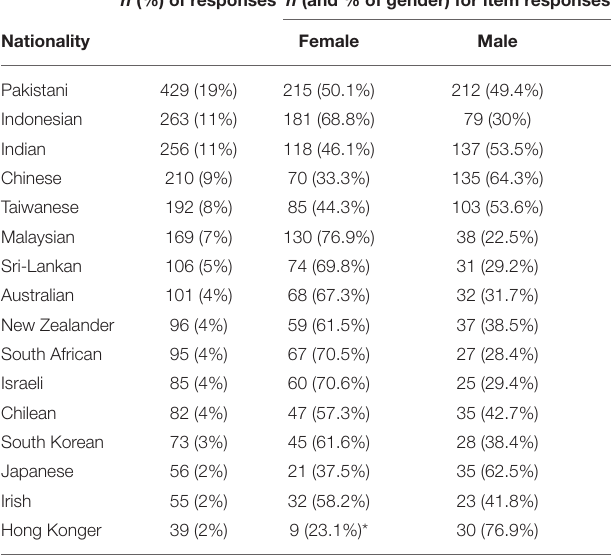
TABLE 1 | Nationality of participants ( N = 2,307). n (%) of responses n (and % of gender) for item responses